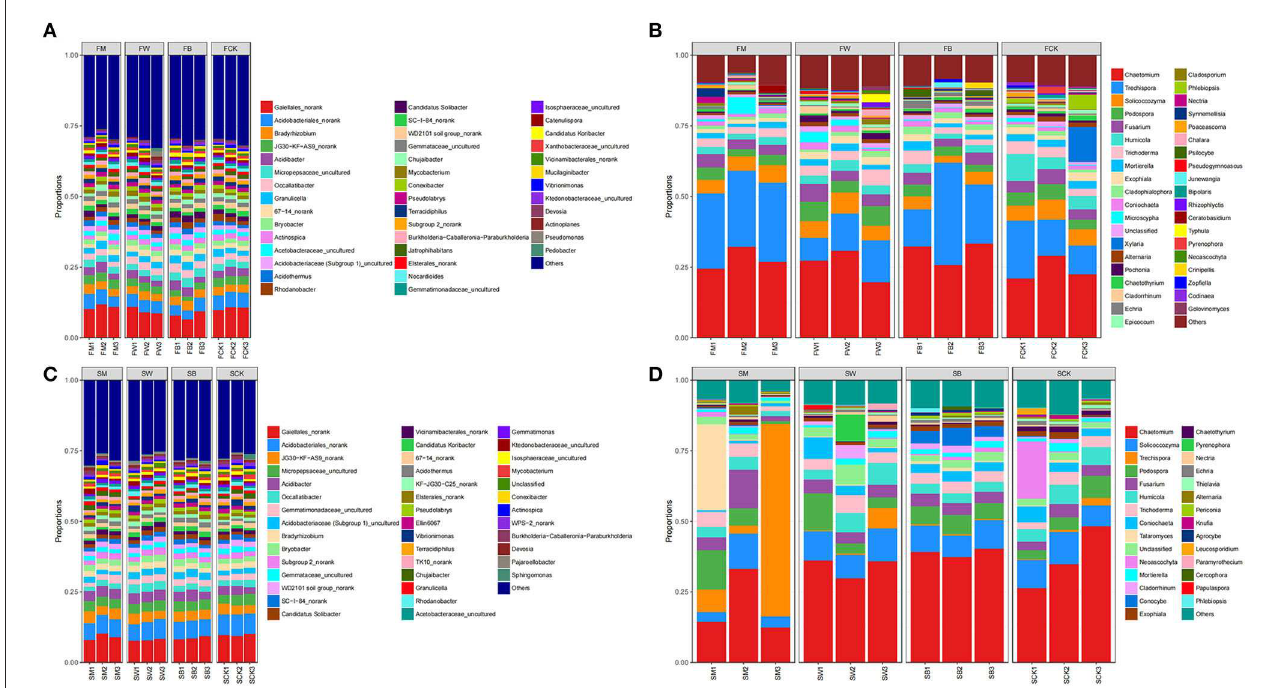
FIGURE4 Microbial composition at the genus level. The 16S rRNA gene-based bacterial (A) and the ITS gene-based fungal (B) community compositions at the genus level subjected to four different treatments in the F group (to achieve the best view effect, the parts with abundance < 1% can be merged with others in the diagram). F represents the season before the maize planting. The 16S rRNA gene-based bacterial (C) and the ITS gene-based fungal (D) community compositions at the genus level after the four treatments in the S group (to achieve the best view effect, the parts with abundance < 1% can be merged in the diagram). S represents the season before wheat